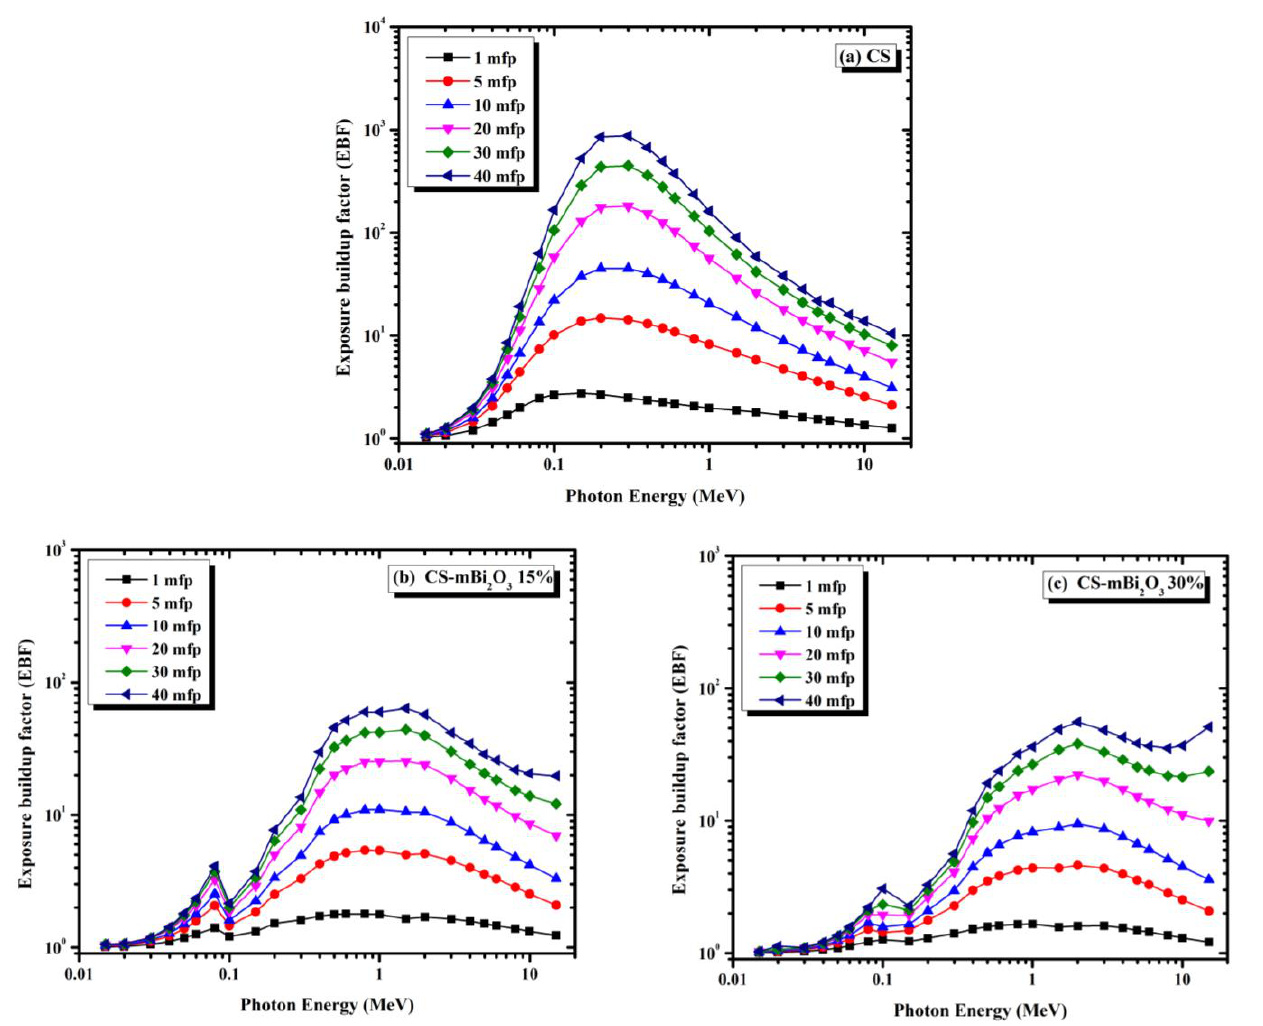
Figure 11. The variation of exposure buildup factor (EBF) with gamma ray energy for different samples.